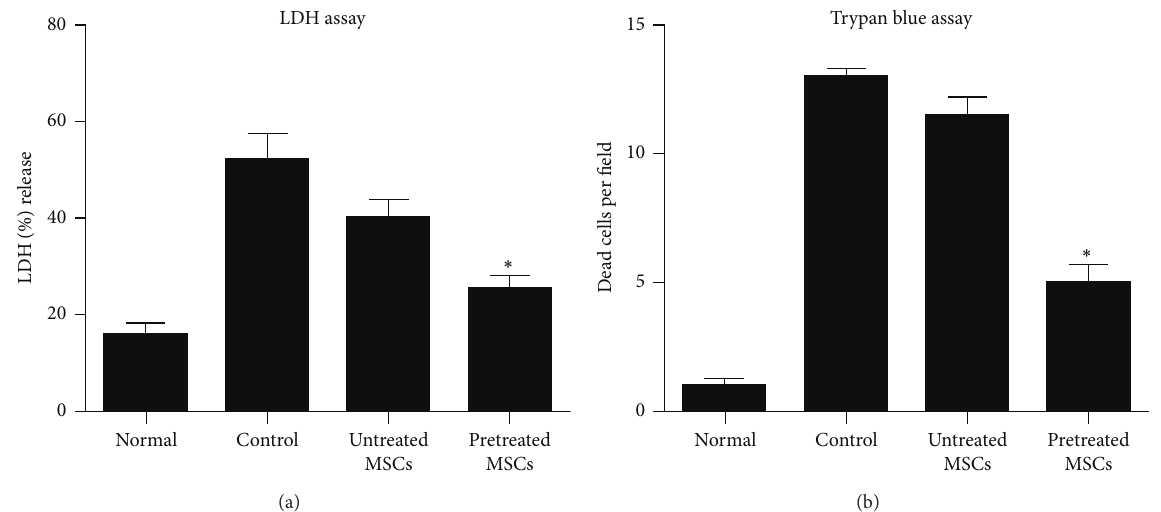
Figure4:EffectsofcytokinespretreatedMSCsininjuredhepatocytescoculturedmodel.(a)LDHreleasewasestimatedinthecellsupernatant. (b) Cell viability was determined by counting damaged cells using trypan blue exclusion test. LDH release was reduced and the number of damaged cells was decreased in cytokines pretreated group as compared with control and untreated MSCs group. All values were expressed as mean + SEM. ∗ 𝑃 < 0.05 versus control and untreated MSCs group.